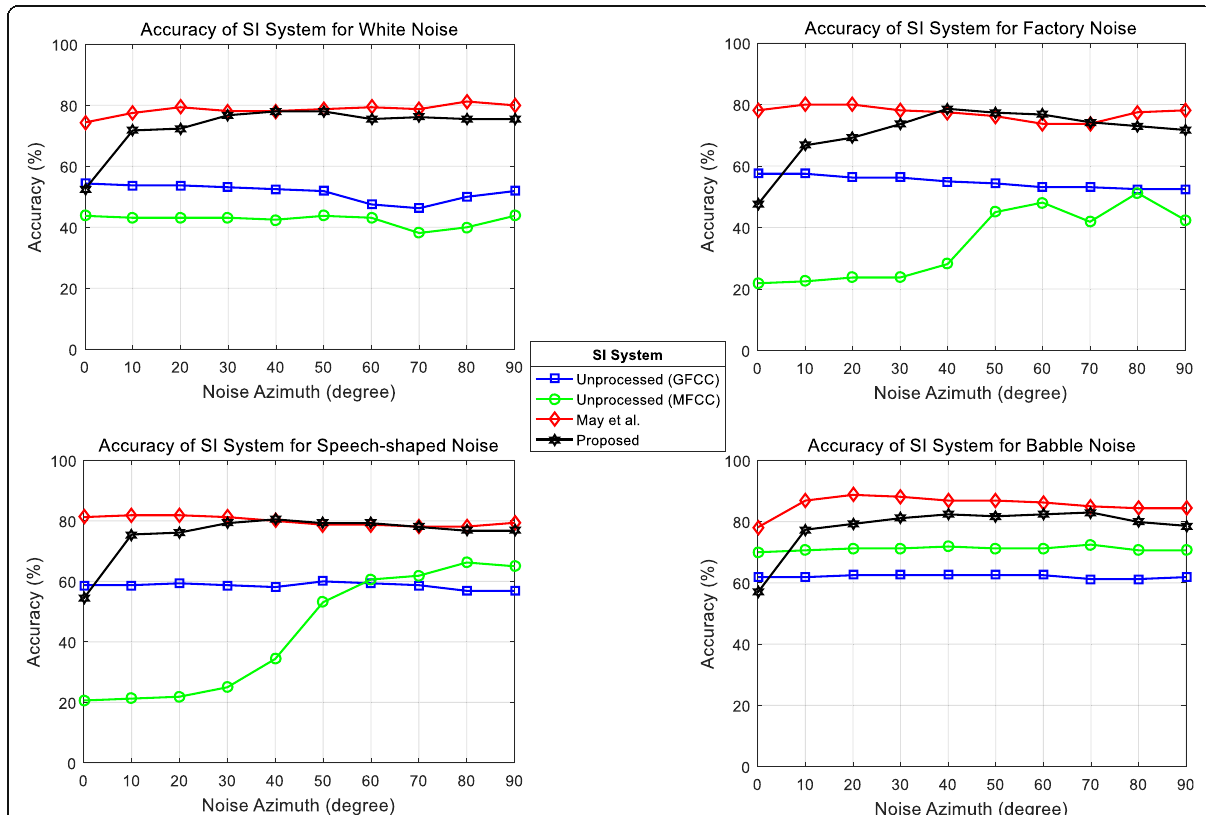
Fig. 8 The accuracy of the SI systems obtained in anechoic and additive noise conditions with four types of noises at SNR = 10